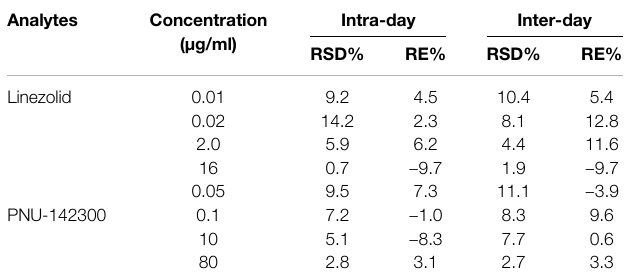
TABLE 1 | The precision and accuracy of linezolid and PNU-142300 in human serum ( n (cid:2)